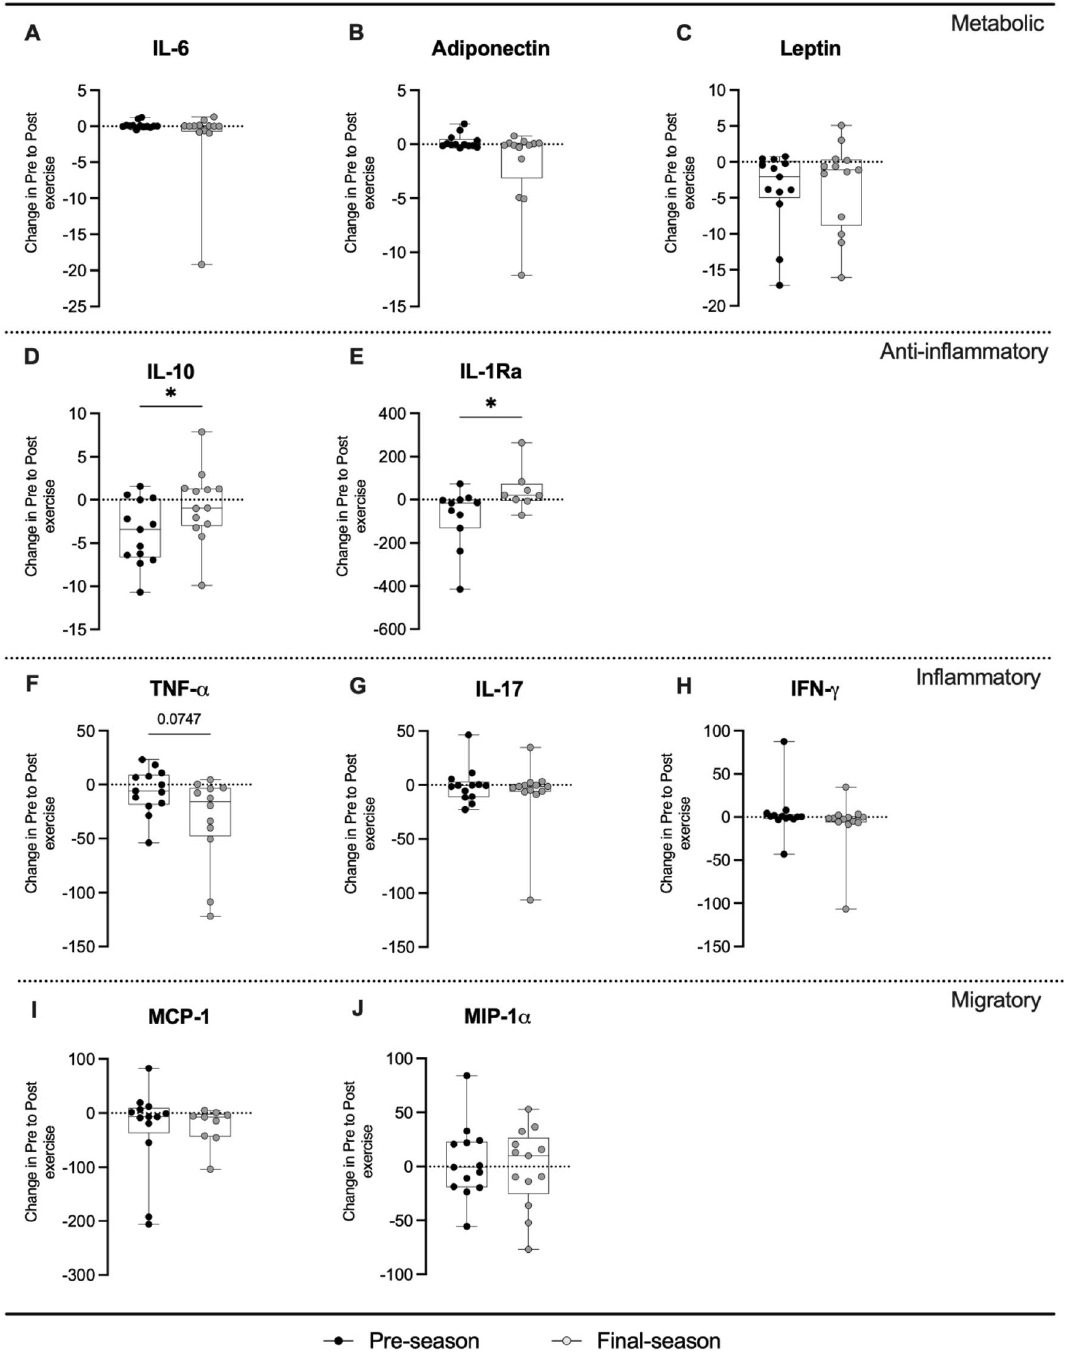
Figure 3. Delta change in cytokine levels relative to the resting value obtained before and after badminton season. Individual data points (dots) for IL-6 (n = 13; A ), adiponectin (n = 13; B ), leptin (n = 13; C ), IL-10 (n = 13; D ), IL-1ra (n = 6; E ), TNF-α (n = 12; F ), IL-17 (n = 13; G ), IFN-γ (n = 13; H ), MCP-1 (n = 9; I ), MIP-1α (n = 13; J ). For display purposes one participant with high variable fold change values is not included in ( A ) (pre-season: 0.00 pg/ml, final-season: –19.18 pg/ml). *P-values indicate differences relative to the